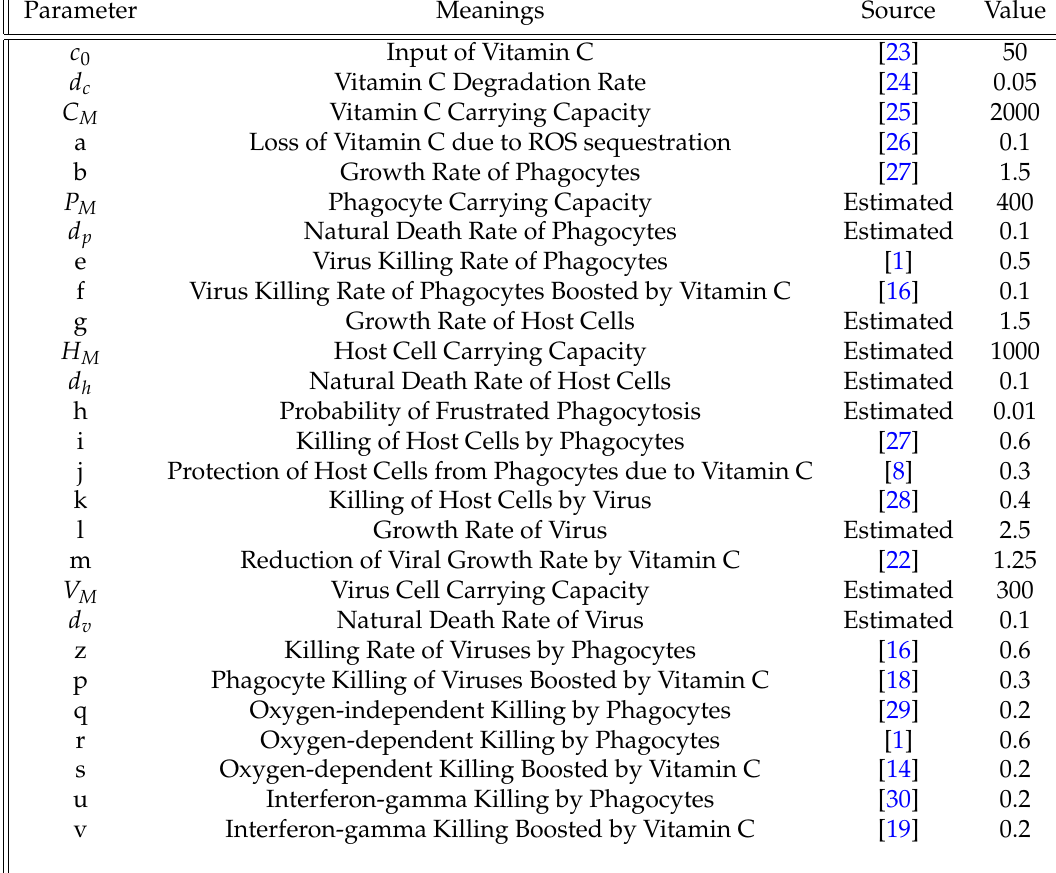
Table 1 represents the base values of the parameters used in creating simulations of the dynamics among Vitamin C, phagocytes, host cells, and viruses under various medical conditions. Table 1. Parameters used in creating